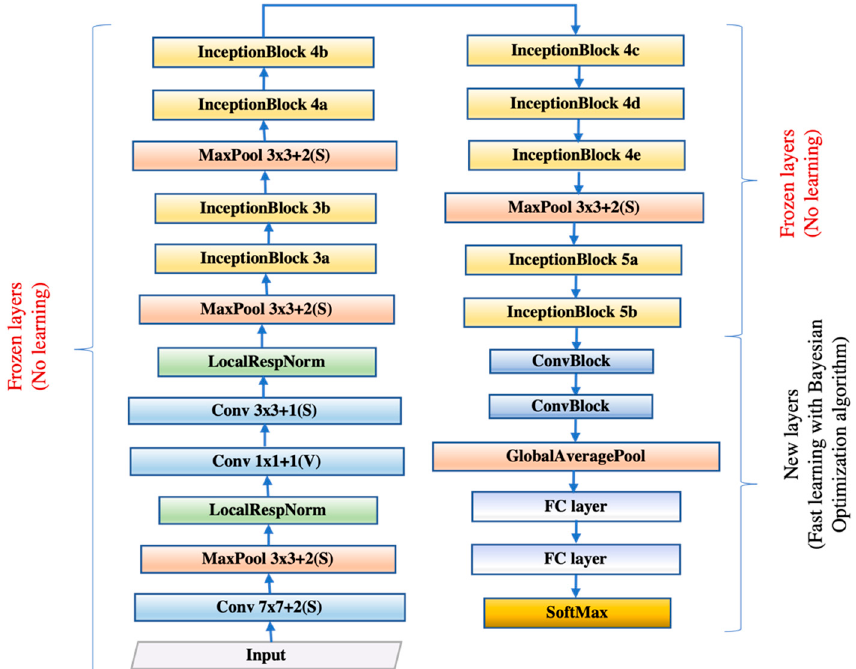
Figure 6. The structure of our proposed GBBNet.